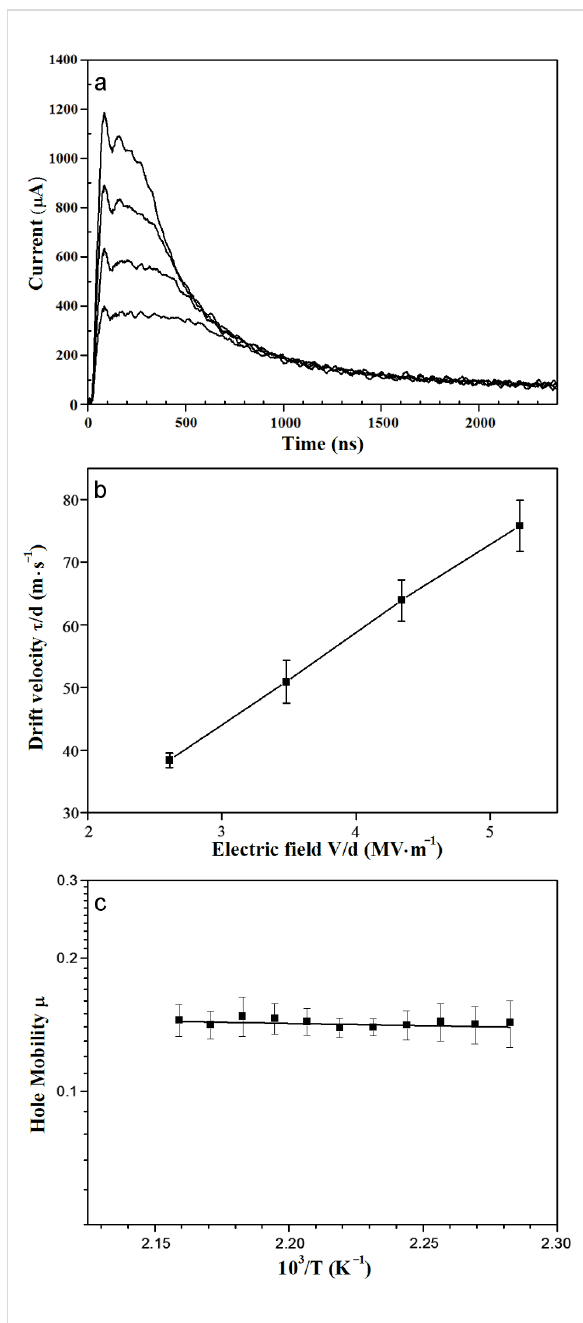
Figure 3: (a) Time-of-flight hole transits for an ITO/ 7c /ITO cell with the liquid crystal in its Col h phase at 185 °C. Applied voltages 60 V (top trace), 80 V, 100 V, 120 V (bottom trace). (b) Drift velocity as a func- tion of electric field (185 °C). (c) Temperature-dependence of the hole mobility within the Col h phase. The error bars represent 2 σ